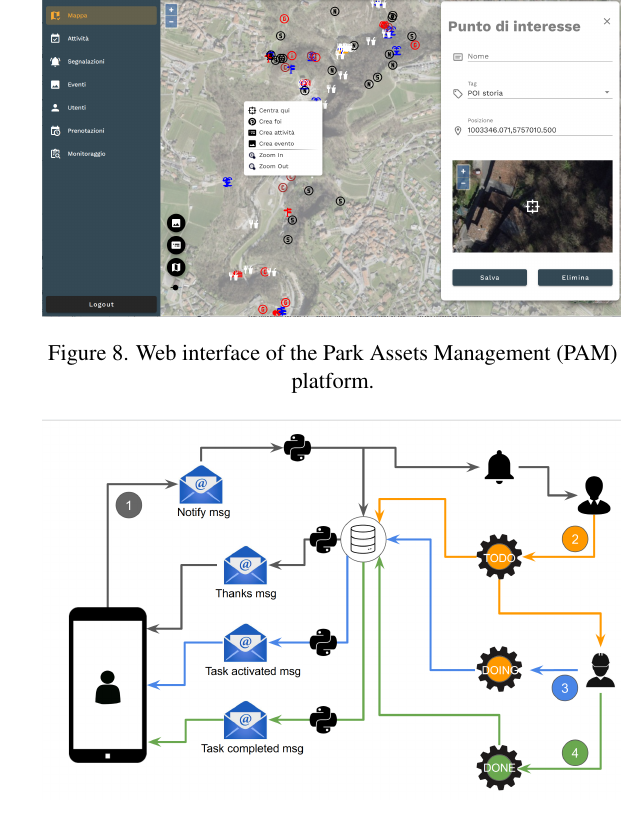
Figure 9. PAM notification system: (1) users make a